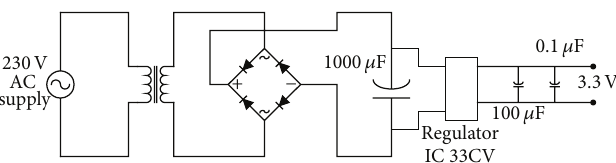
Figure 6: Power supply circuit for dsPIC33EP256MC202